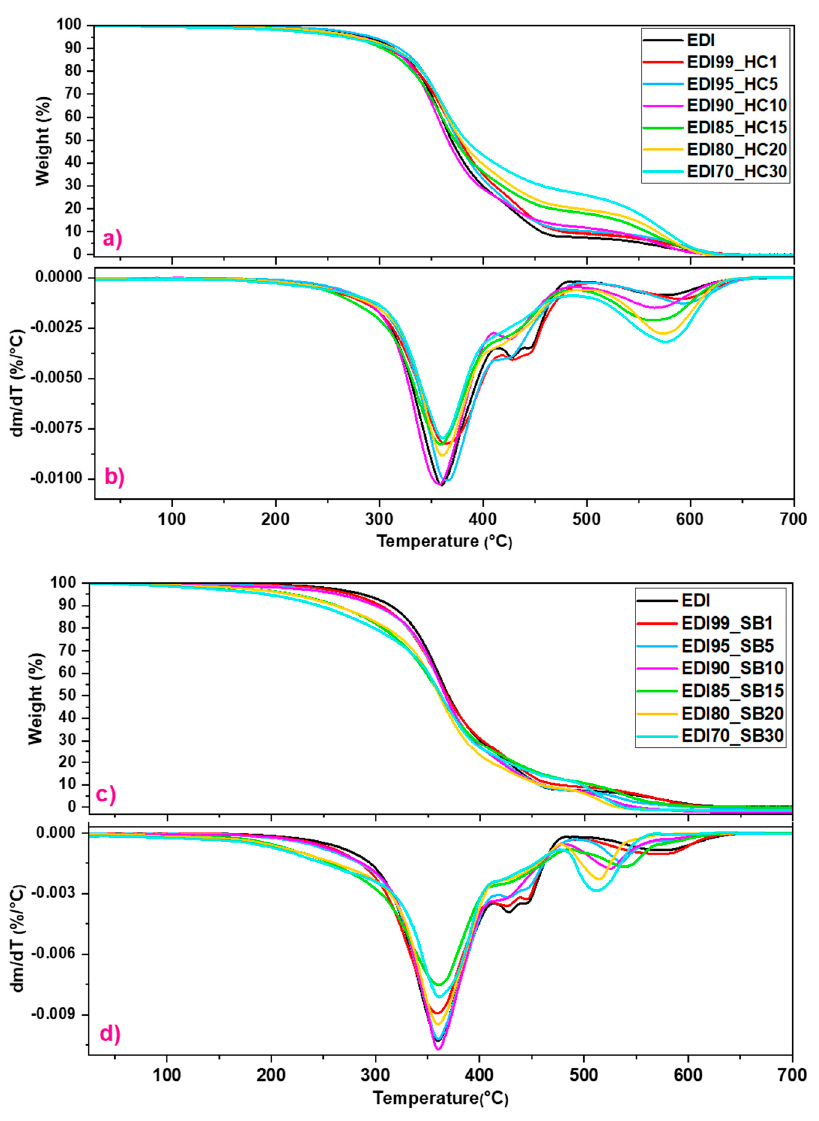
Figure 3. TGA/DTG curves for the ( a , b ) HC-based materials and ( c , d ) SB-based materials in oxidative environment, heating at 10 ◦